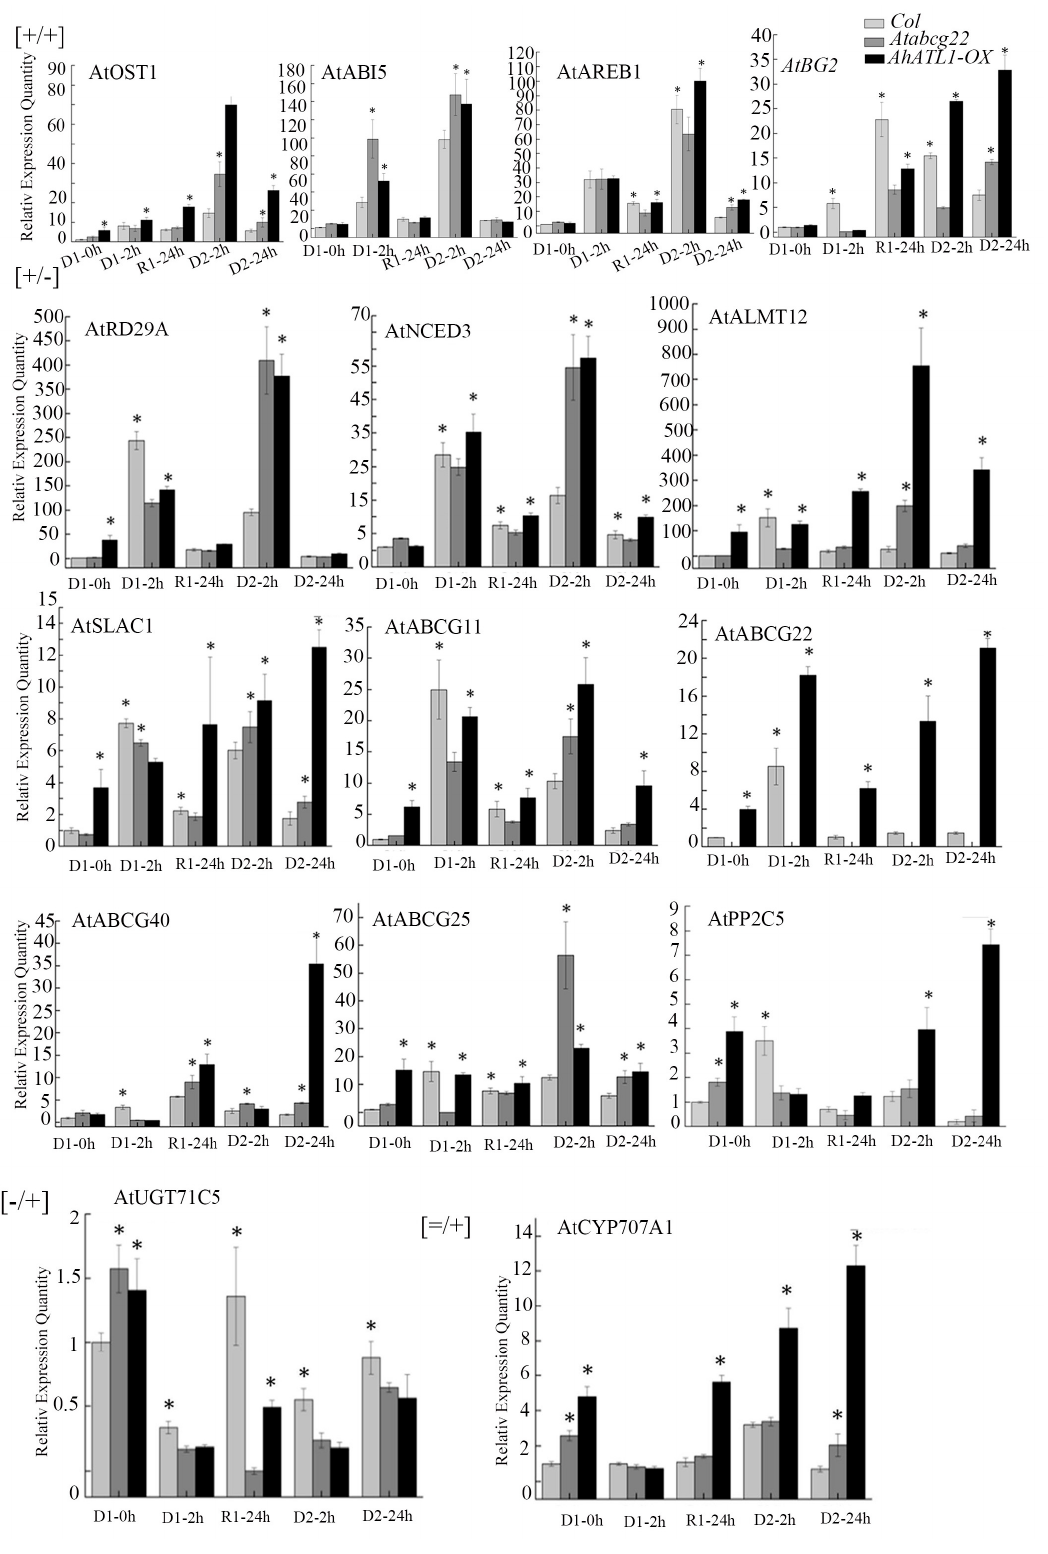
Figure 3. Changes in the expression of ABA and stress response related genes under drought training. [+/+], [+/-], [-/+], and [=/+] indicate the expression patterns of each gene in wild-type Col. ‘*’ Indicates a significant difference between AhATL1-OX, Atabcg22 , and Col plants under the same dehydration and rehydration treatment conditions (P < 0.05). Asterisks indicate significant differences from Col in D1 0h (Student’s t test P values, * p < 0.05).